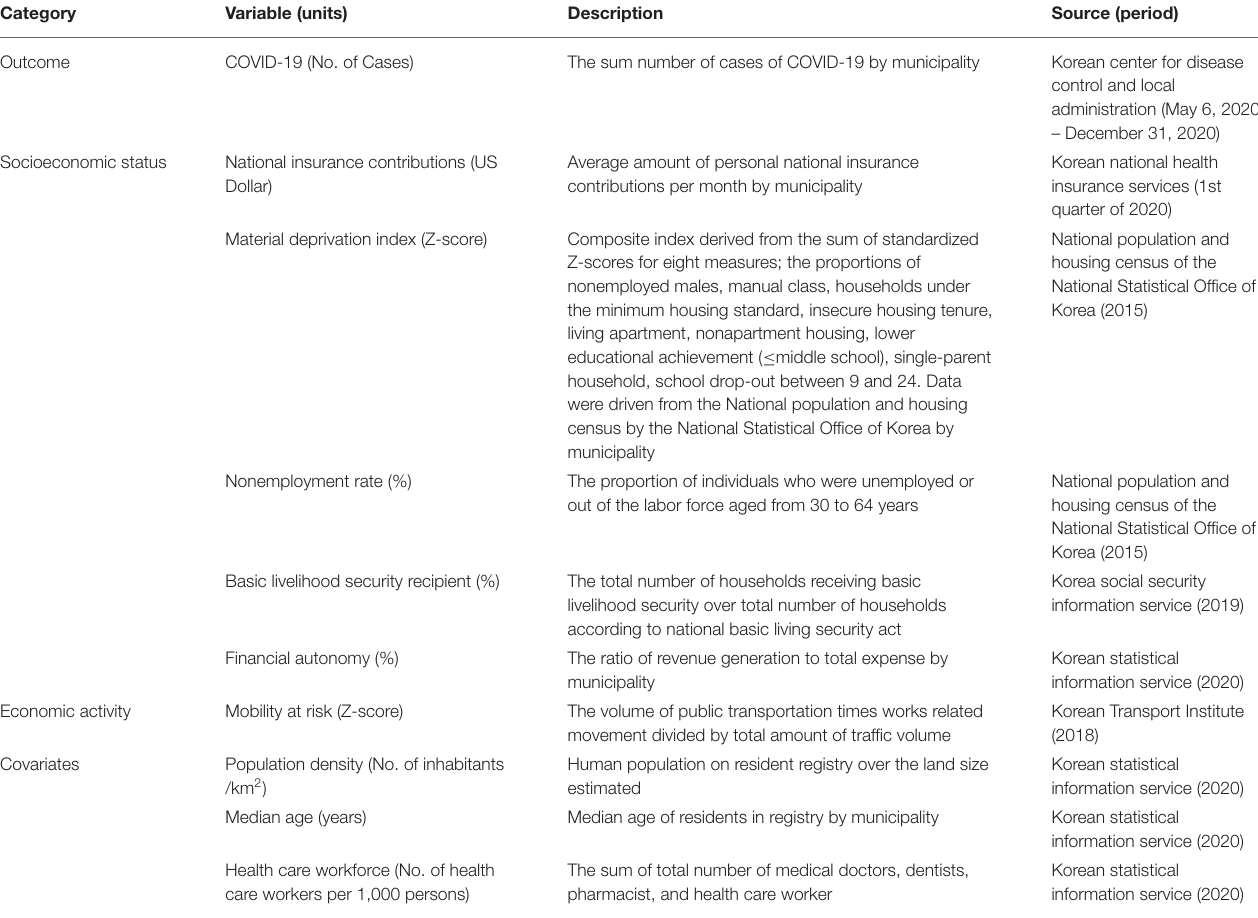
TABLE 1 | Description of the variables used in the study with the source of